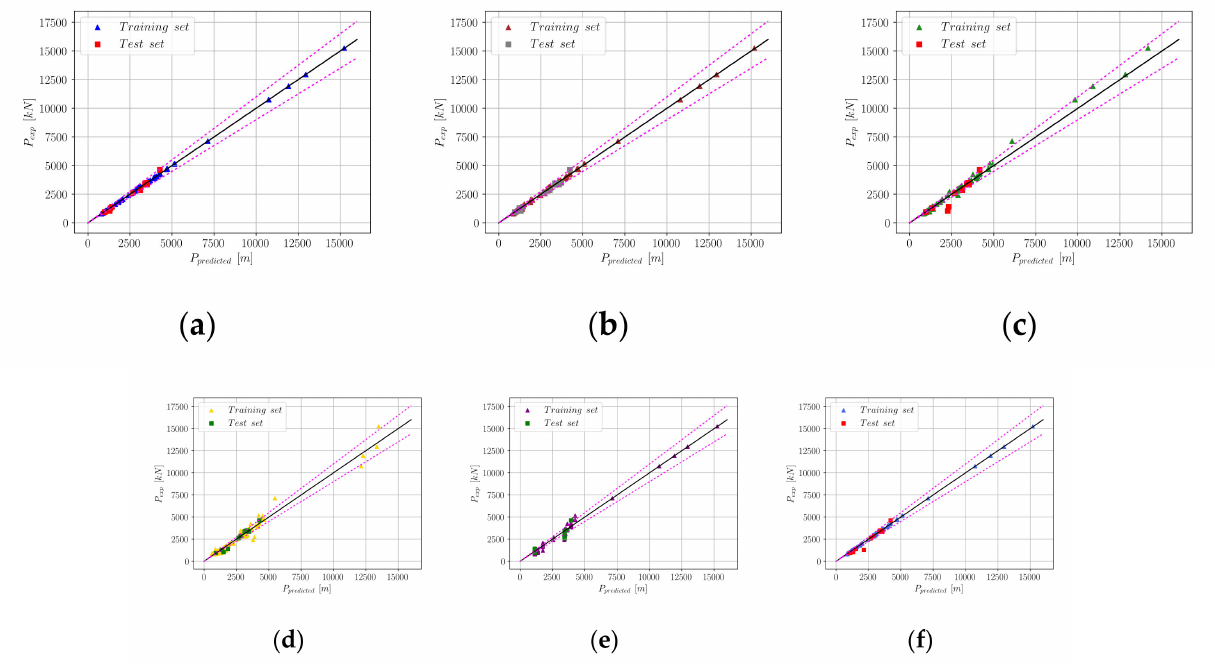
Figure 3. Comparison of experimental and predicted p values; ( a ) XGBoost; ( b ) GBM; ( c ) Random Forest; ( d ) Lasso; ( e ) AdaBoost; ( f )